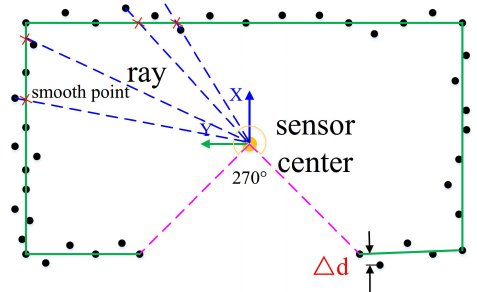
Figure 6. Douglas-Peucker smoothing: smoothed points (red) re- sult from the projection of the input points (black) on a polygonal approximation of the scanline (green) for the laser